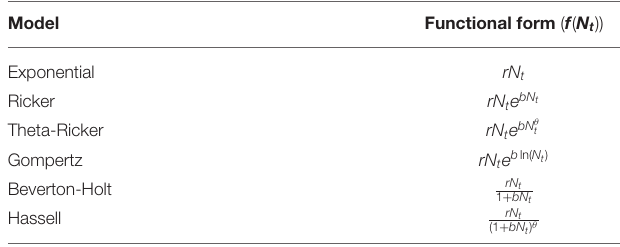
TABLE 2 | Forms of density dependence used in the population dynamics